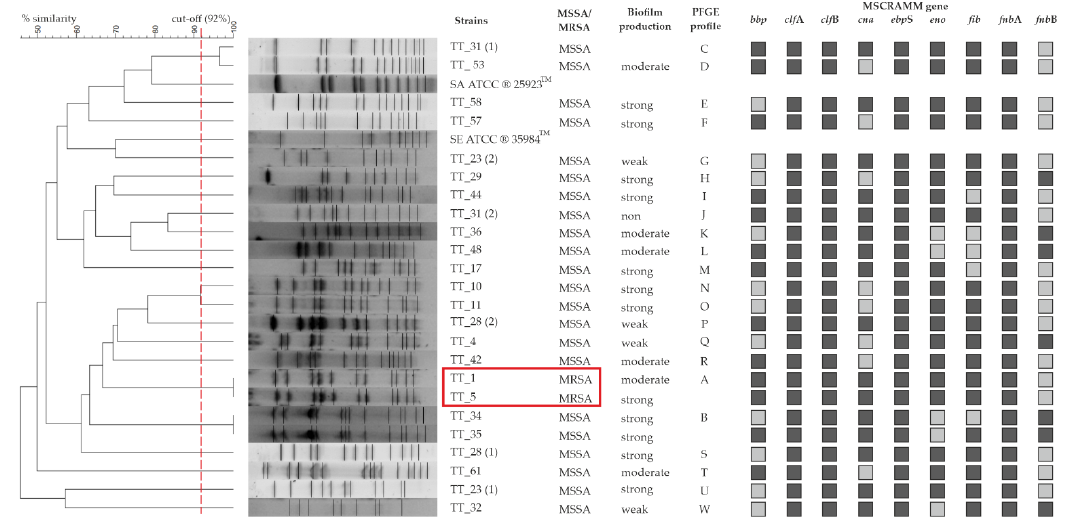
Figure 2. Macrorestriction analysis of the chromosomal DNA from S. aureus isolated from trache- ostomy tubes after digestion with the restriction enzyme Sma I. Dendrogram resulting from com- puter-assisted analysis of the PFGE profiles (GelCompar II, Dice, UPGMA, 1% optimization, 1% tolerance). LEGEND: the MRSA strains (clone A) are marked with a red box, while the cut-off point (92%) is marked with the red dashed line. A dark gray square indicates the presence of the MSCRAMM family gene, and a light gray square indicates no gene.